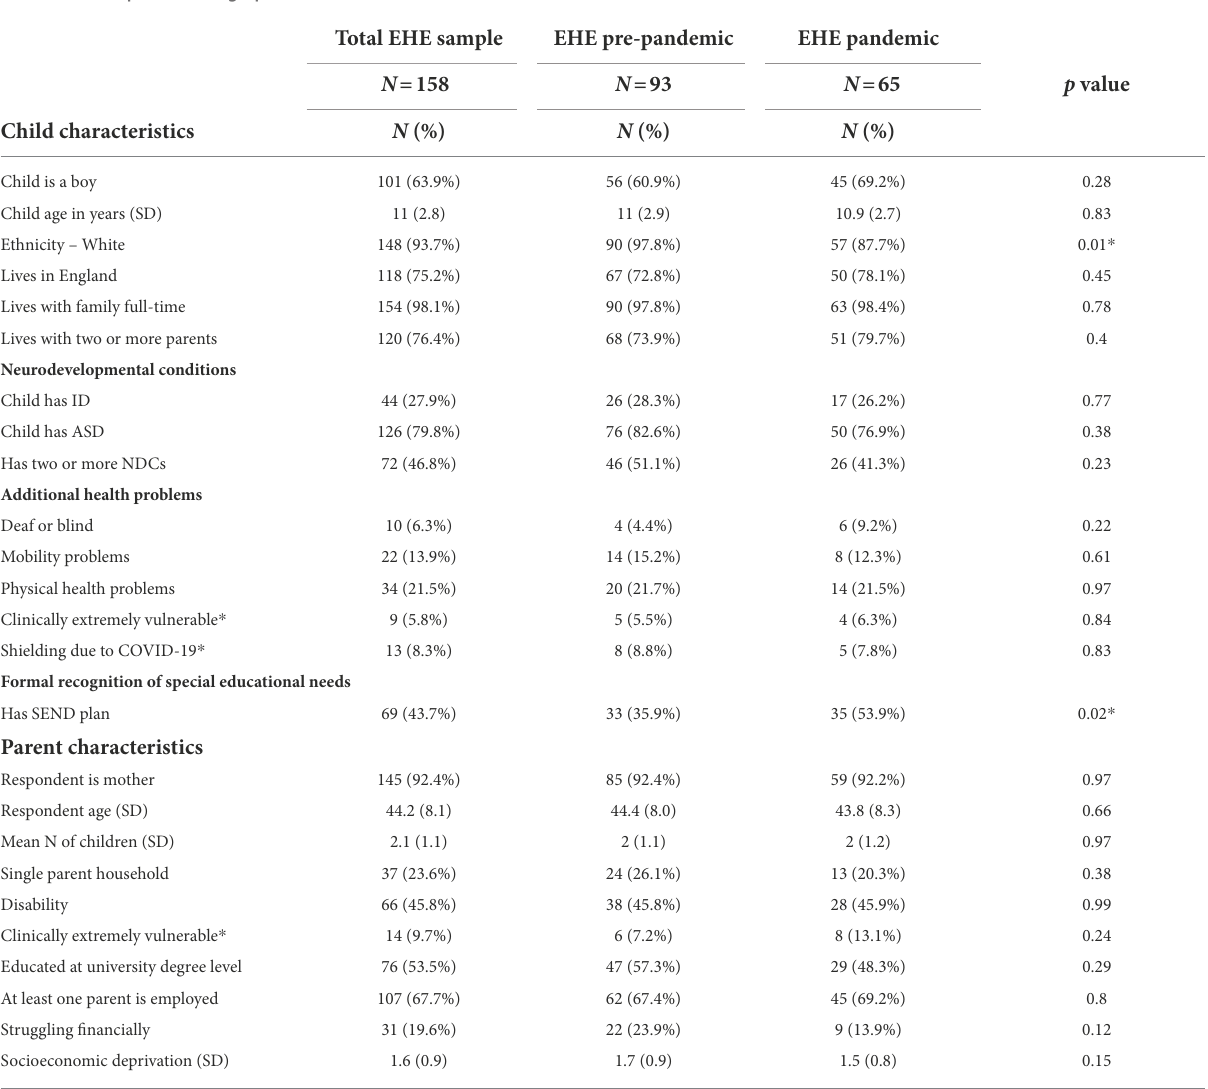
TABLE 1 Participants’ demographic